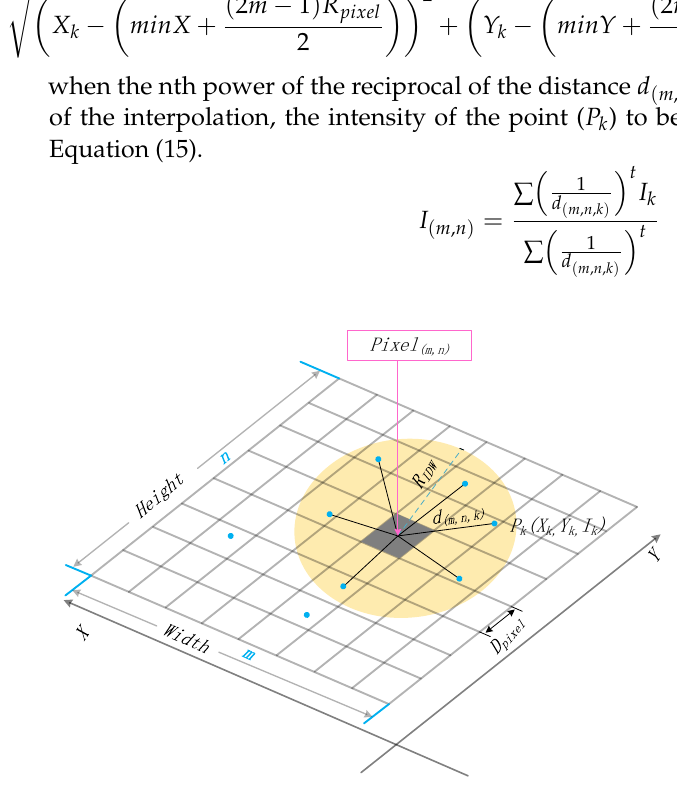
Figure 4. Sketch map of Inverse Distance Weighted interpolation.